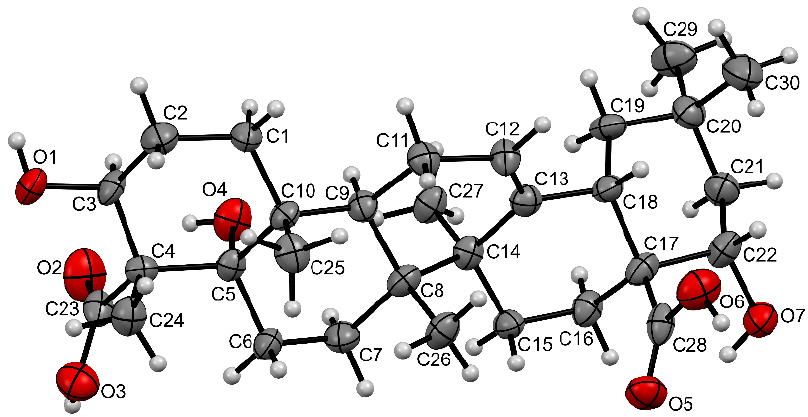
Figure 9. Molecular structure of the OA metabolite as represented by non-hydrogen atoms (30% probability ellipsoids). Solvent and water molecules are not shown.